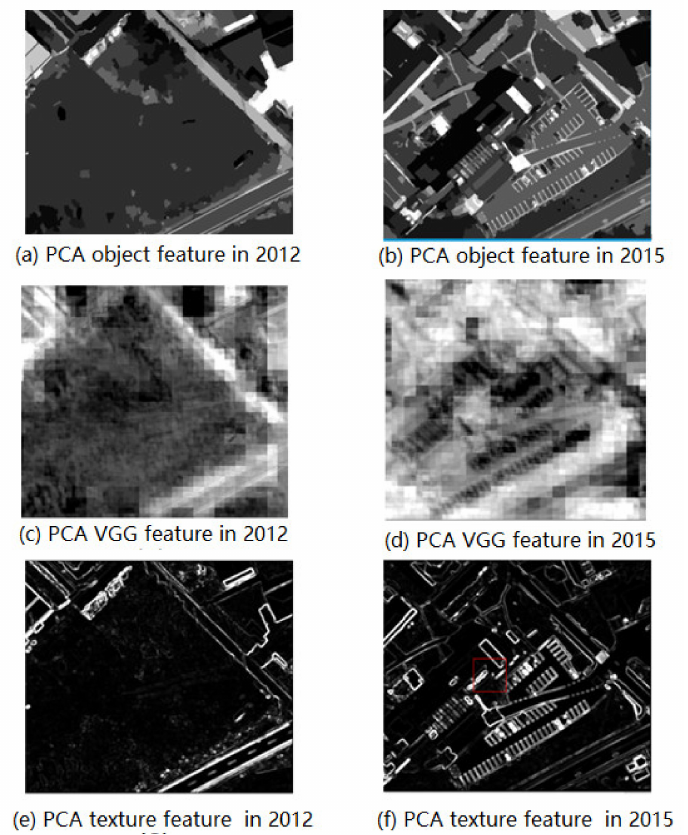
Figure 8. The principal components of